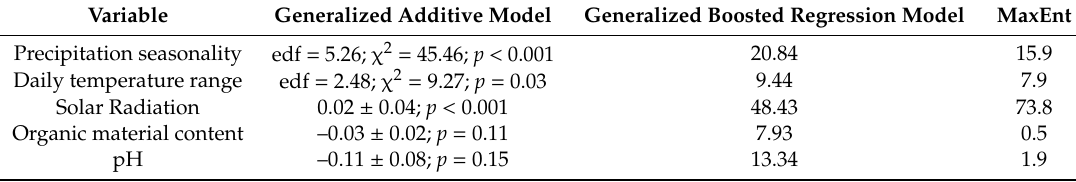
Table 3. Set of variables selected for constructing the species distribution models and their relative importance according to the three algorithms considered: Estimated parameters and variable contributions are only given for non collinear variables (all pairwise Pearson |r| < 0.7 [32]) introduced in the models (Figure S2 in Supplementary Material). For the Generalized additive model, estimated β (±s.d.) and p -values are given for the linear terms, whereas estimated degrees of freedoms (edf) and p -values based on χ 2 test for the smoothed terms. For the Generalized boosted regression mode and the maximum entropy model MaxEnt, the variable relative influence and permutation importance are reported, respectively.